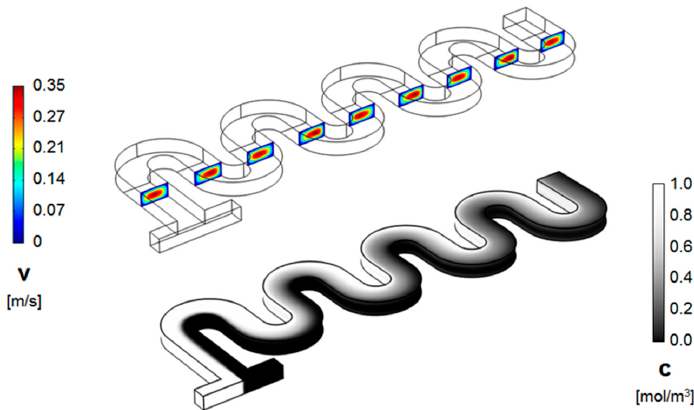
Figure 3. Velocity magnitude (cross-sectional maps) ( top ) and concentration distribution (surface map) ( bottom ) along the channel of a standard serpentine micromixer ( R in = W /2 = 100 μ m, and Re = 20).